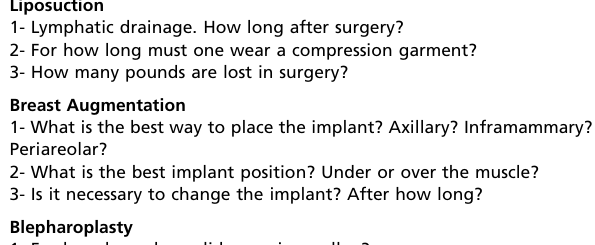
Table 1 - Results for the Three Most Frequently Asked Questions among YouTube Users for each Surgery. Liposuction 1- Lymphatic drainage. How long after